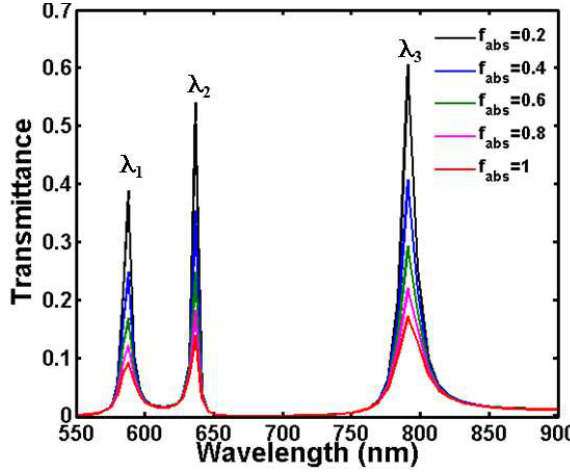
Fig. 4. Transmission spectra of silver nanoslit array with different metal absorption factors of f abs .